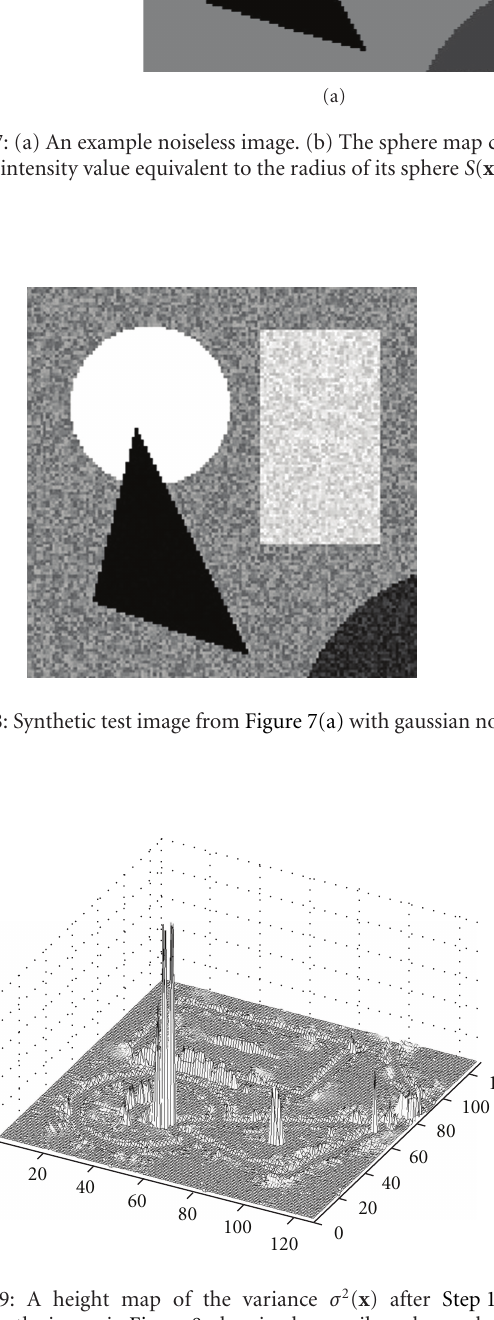
Figure 9: A height map of the variance σ 2 ( x ) after Step 1 is applied to the image in Figure 8, showing large spikes where spheres encounter two boundaries at once, canceling VSS gradient and growing too large.